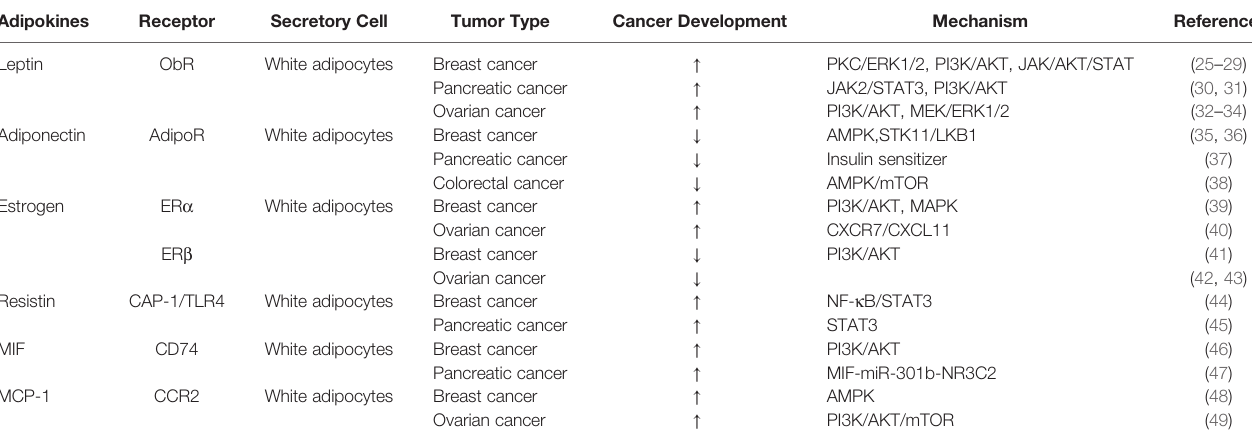
TABLE 1 | Effect of Adipokines on Tumor Progression and its Mechanism.